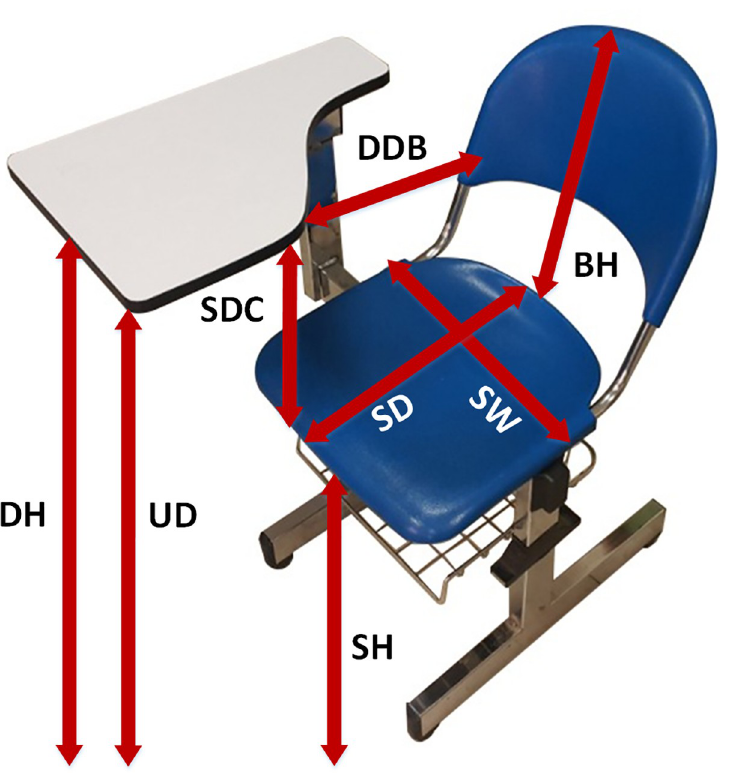
Fig 3. Representation of the chair with an attached table